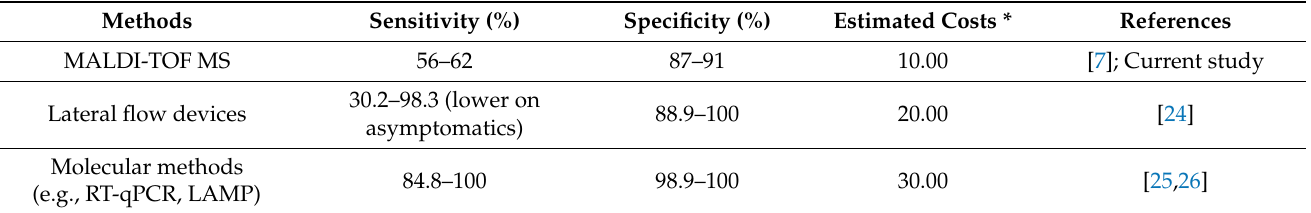
Table 1. Comparison between the cost and performance of SARS-CoV-2 detection methods available at retail in